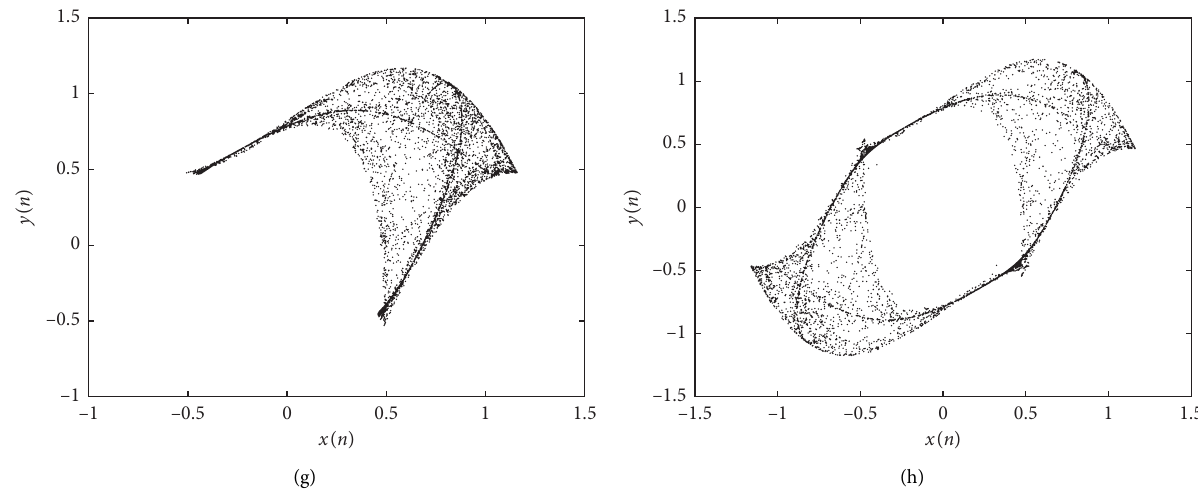
: (a) c � 0 . 20 (b) c � 0 . 25, (c) c � 0 . 28, (d) c � 0 . 29, (e) c � 0 . 40, (f) 02